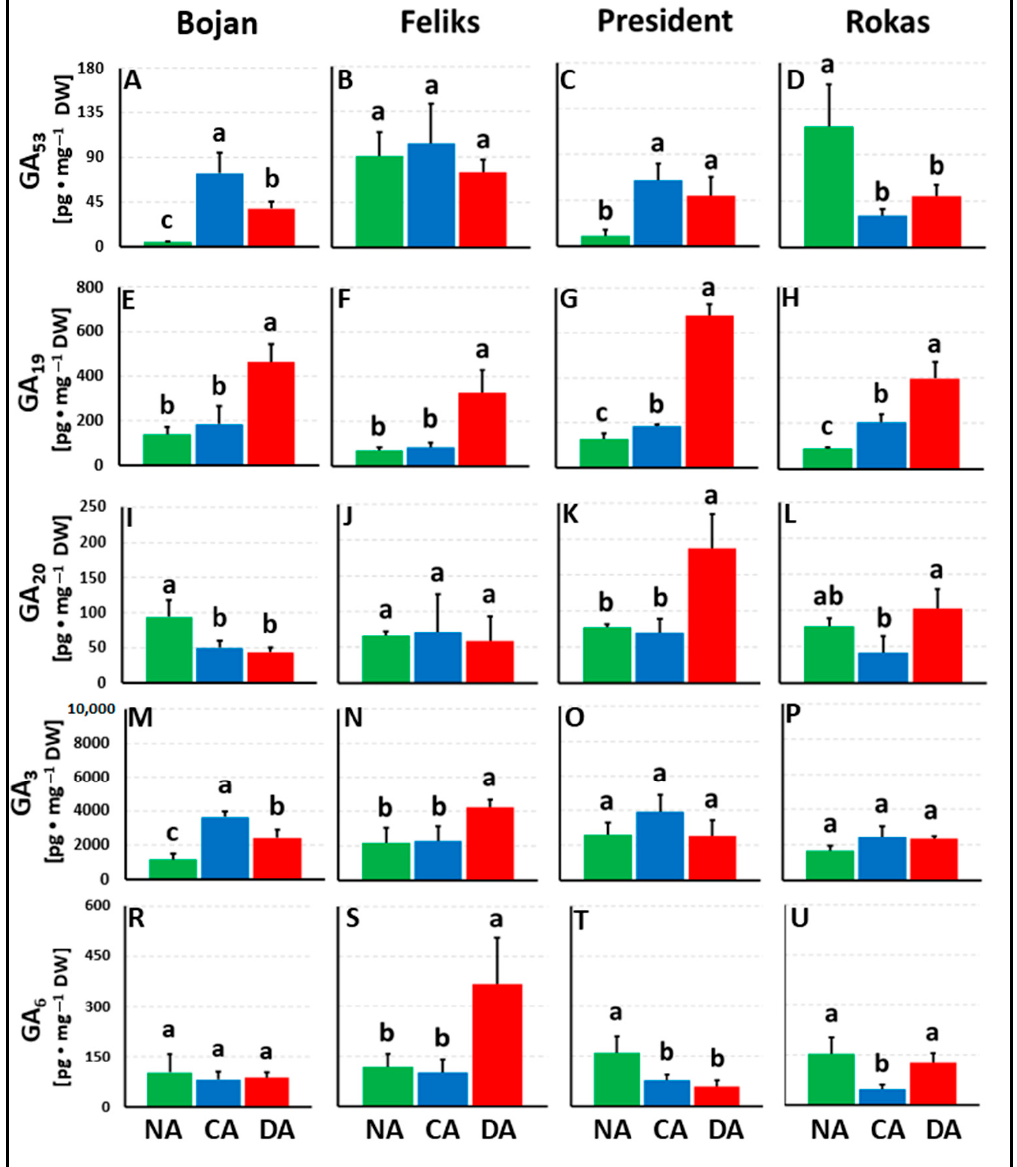
Figure 3. Content of the gibberellins GA 53 , GA 19 , GA 20 , GA 3 and GA 6 in four cultivars of the non-acclimated (NA), cold-acclimated (CA) and deacclimated (DA) oilseed rape. The gibberellins are presented in order based on the biosynthetic pathway from precursor GA 53 via GA 19 and GA 20 to their active forms GA 3 and GA 6 (according to [33]). ( A – D )—GA 53 ; ( E – H )—GA 19 ; ( I – L )—GA 20 ; ( M – P )—GA 3 and ( R – U )—GA 6 . Values marked with the same letters (within each cultivar separately) were not significantly different according to the Duncan test ( p ≤ 0.05 ).